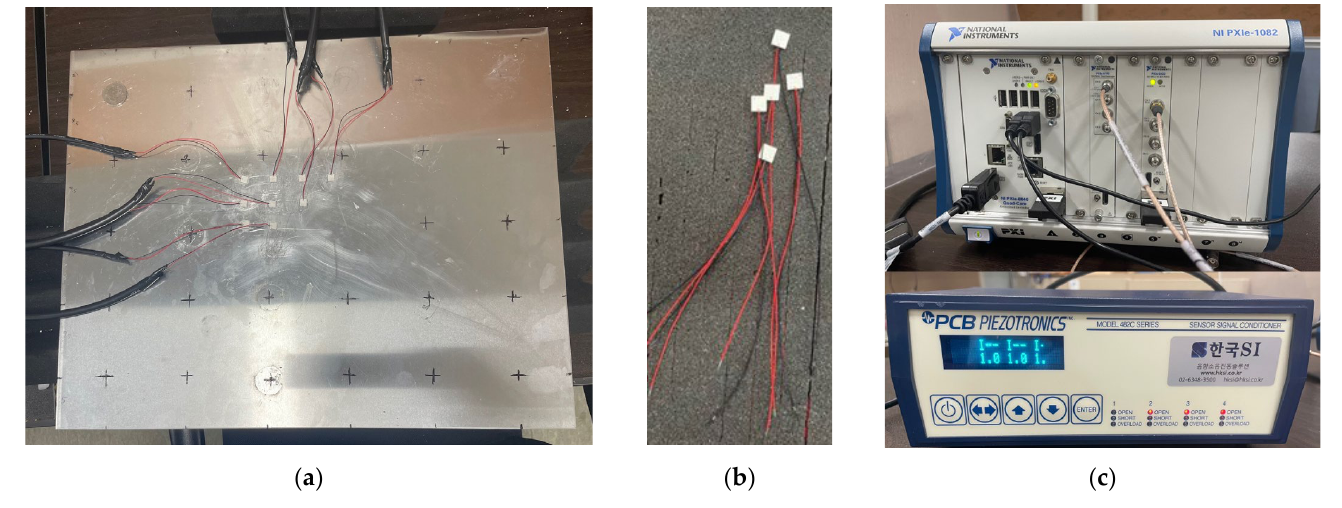
Figure 15. Photos of experimental setup: ( a ) transducer array and defect attached on aluminum panel; ( b ) piezoelectric transducer (7 mm × 7 mm, APC International, Ltd., Mackeyville, PA, USA); ( c ) NI DAQ system equipped with waveform generator (NI-PXIe-5423) and oscilloscope module (NI-PXIe-5172) and signal conditioner (482C24, PCB PIEZOTRONICS Inc., Depew, NY, USA).